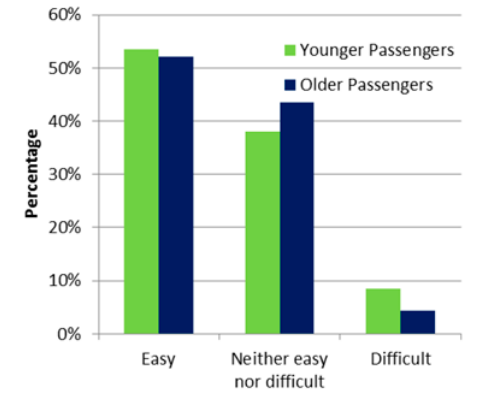
Fig. 2. Usability by age